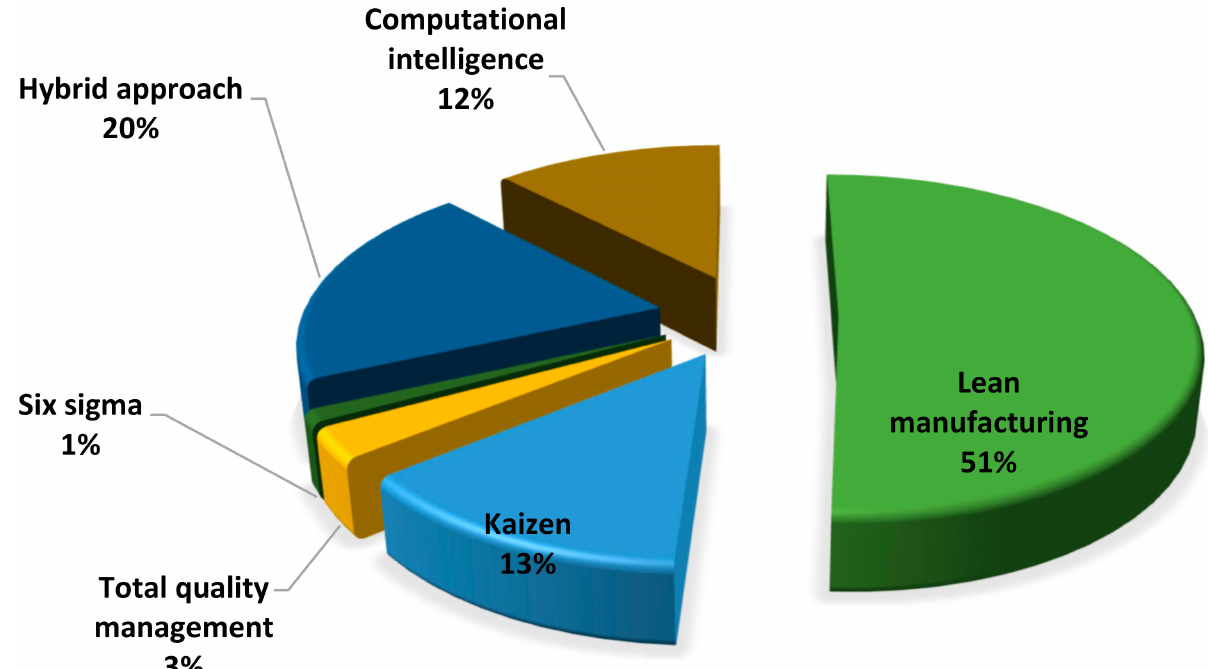
Figure 10. Contribution of process optimization approaches in